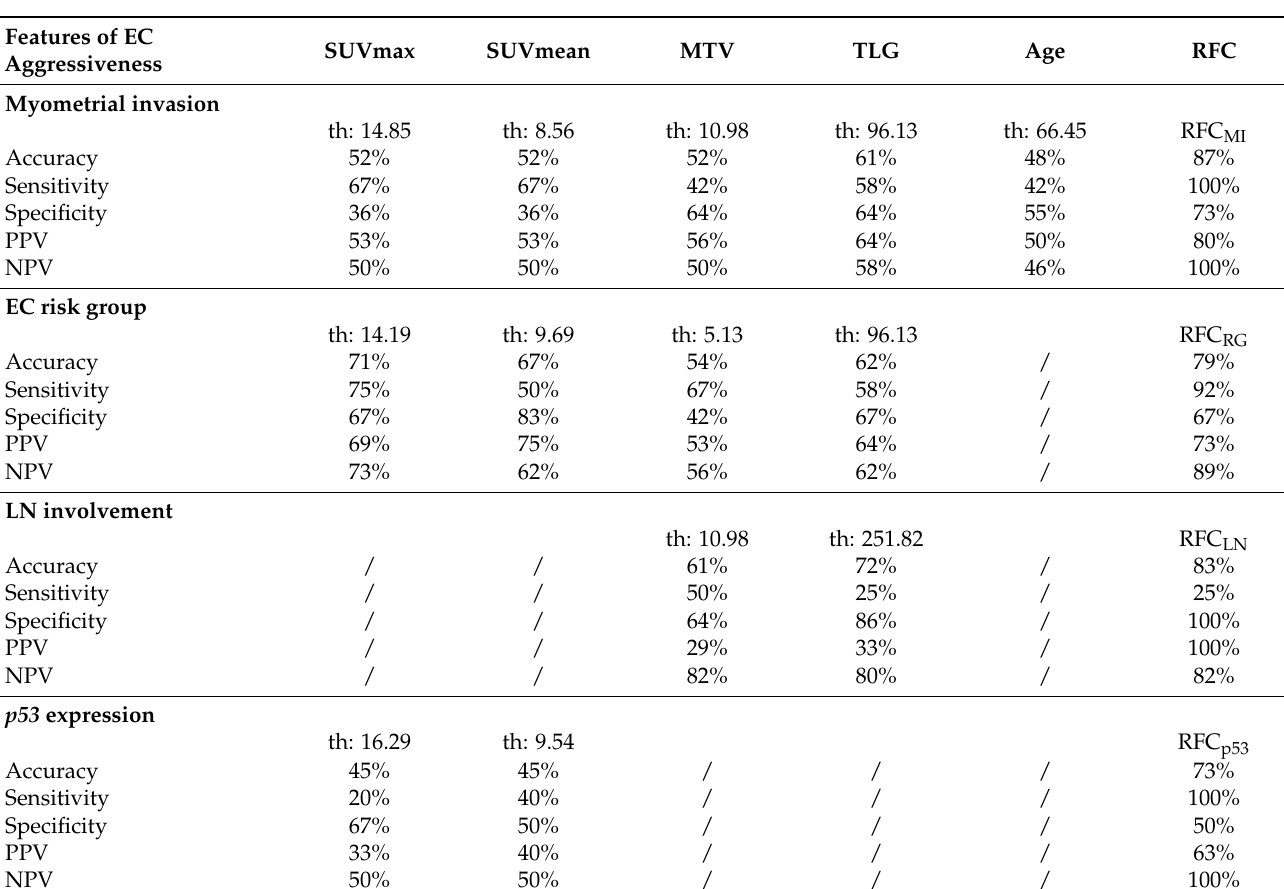
Table 4. Predictive performances of 18 F–FDG PET and clinical parameters. alone and combined in Random Forest Classifiers. on the validation